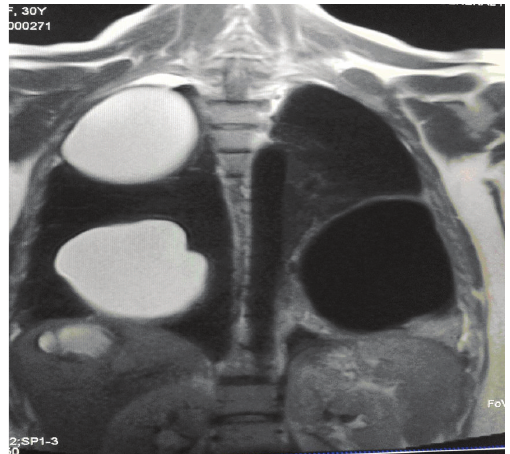
Figure 3: MRI of the thorax showed ruptured hydatid cyst of the left lung and multiple other intact hydatid cysts of the right lung and liver.